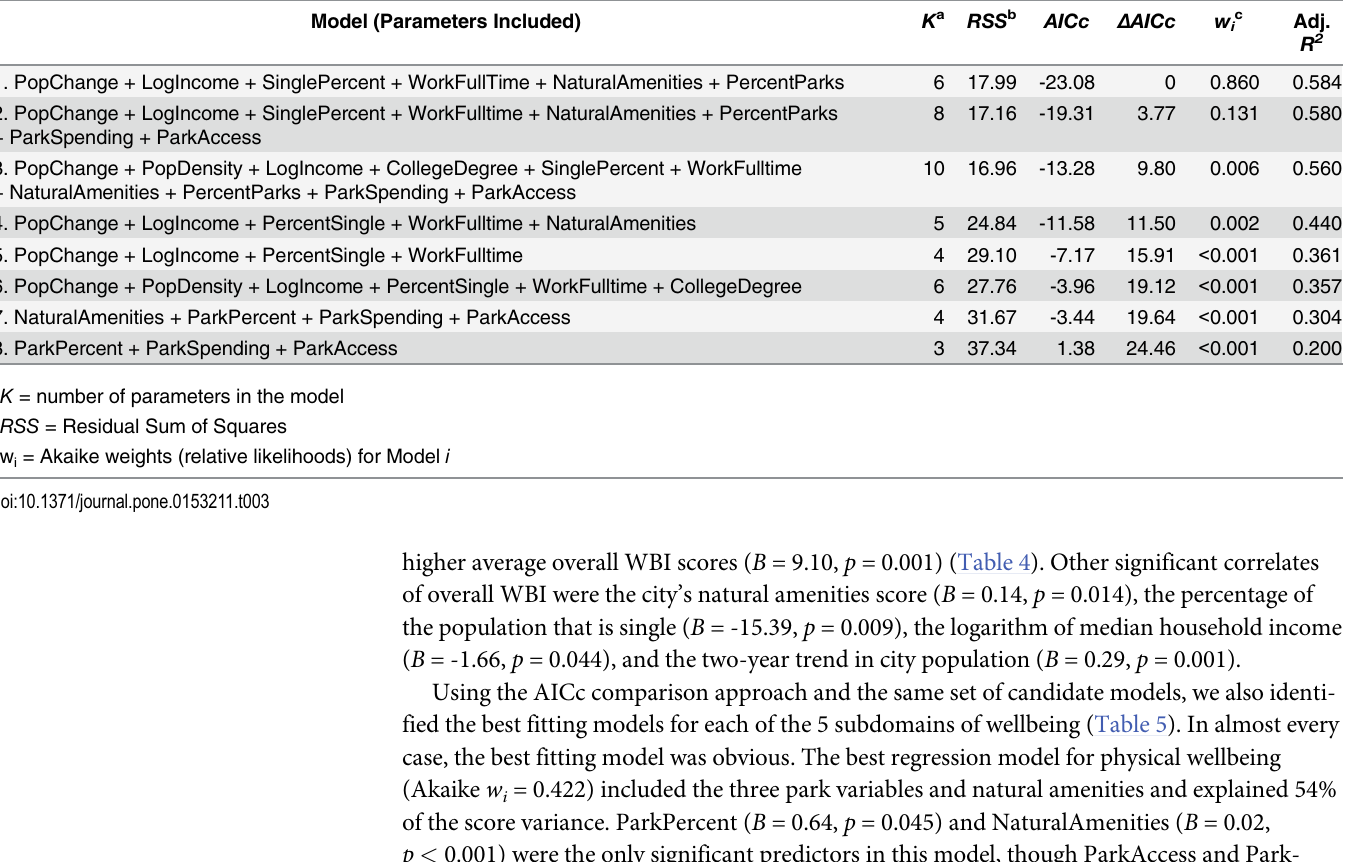
Table 3. Model Selection Overview for Variables Associated with Overall Wellbeing Scores in U.S. Cities (n = 44).